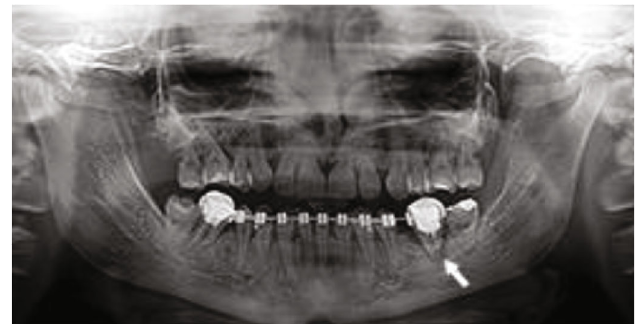
Figure 3: Panoramic radiograph taken at age of 29 right before prosthodontic treatment.